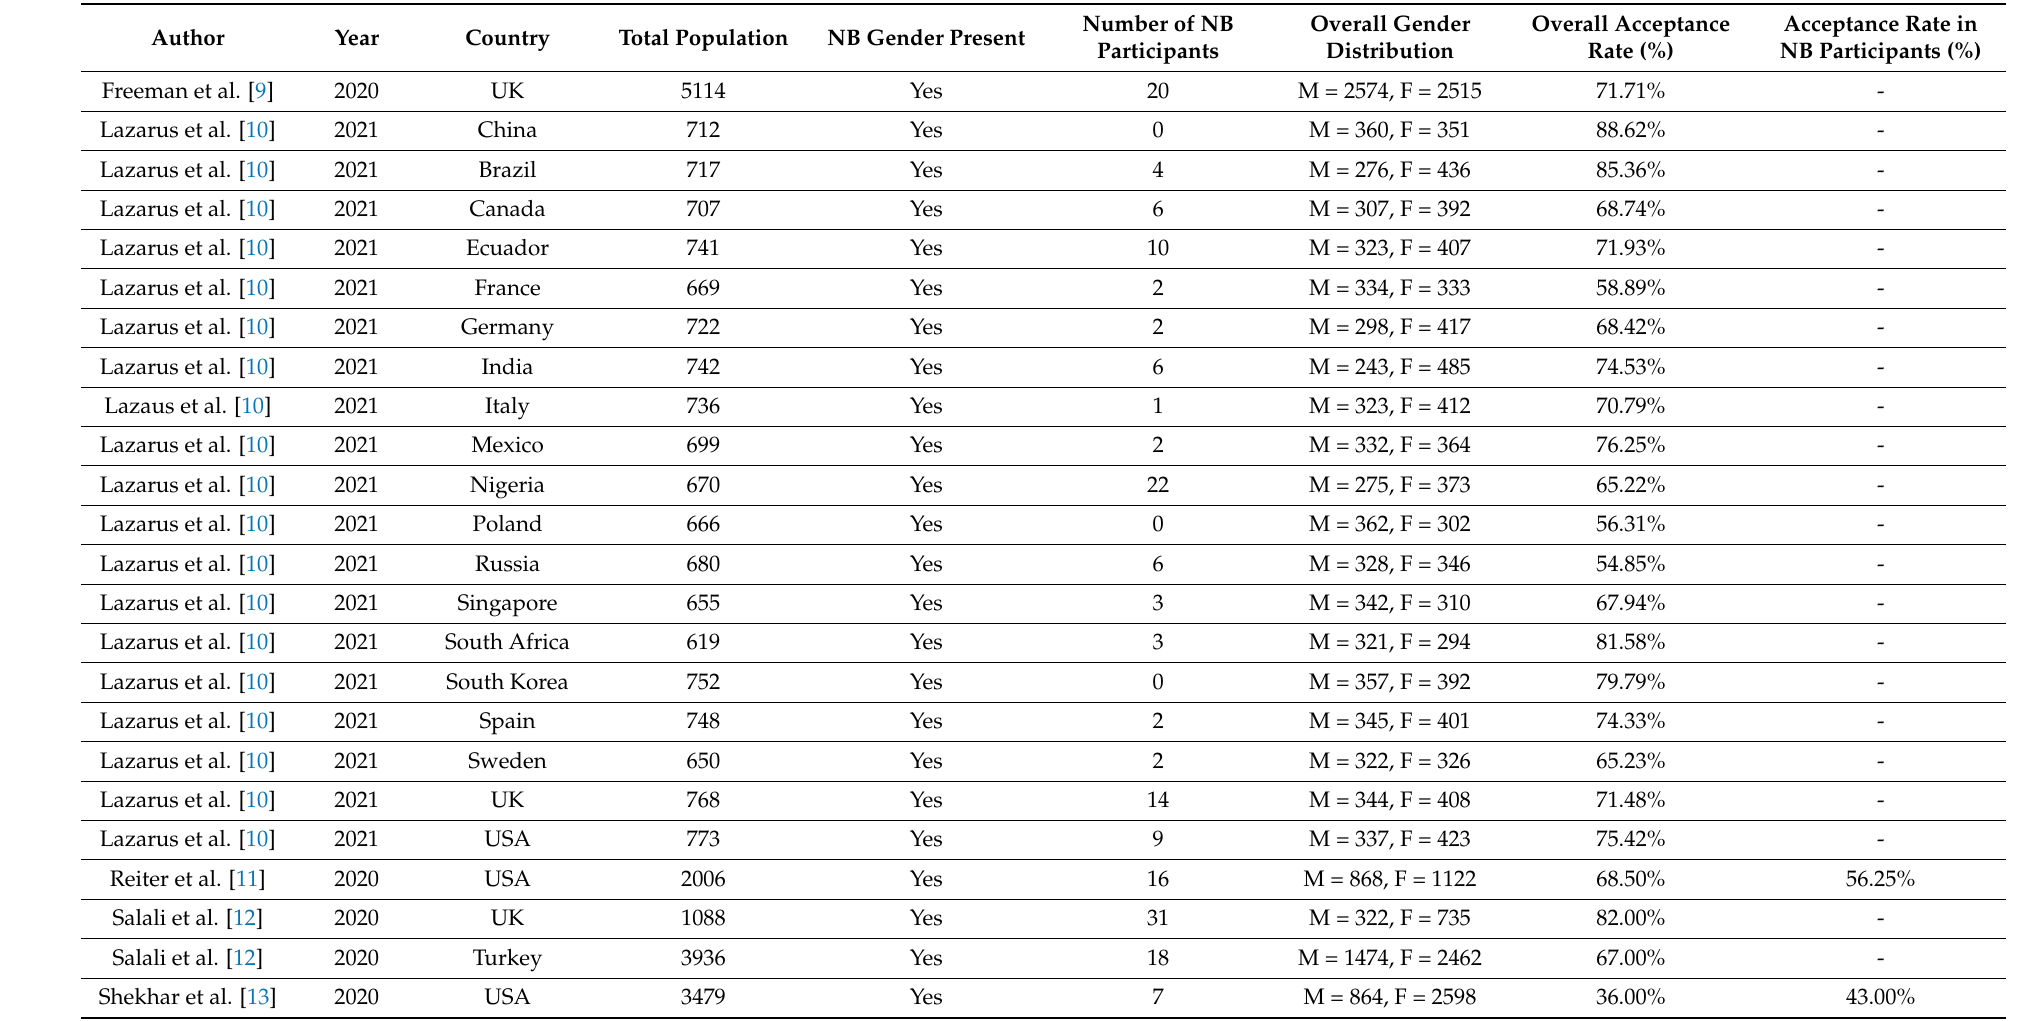
Table 1. Summary of all studies